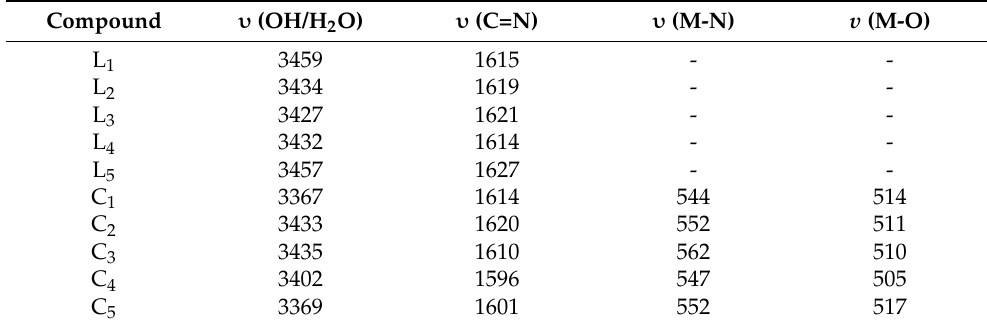
Table 3. FT-IR absorption bands (in cm − 1 ) of the Schiffbases and their Co(II)